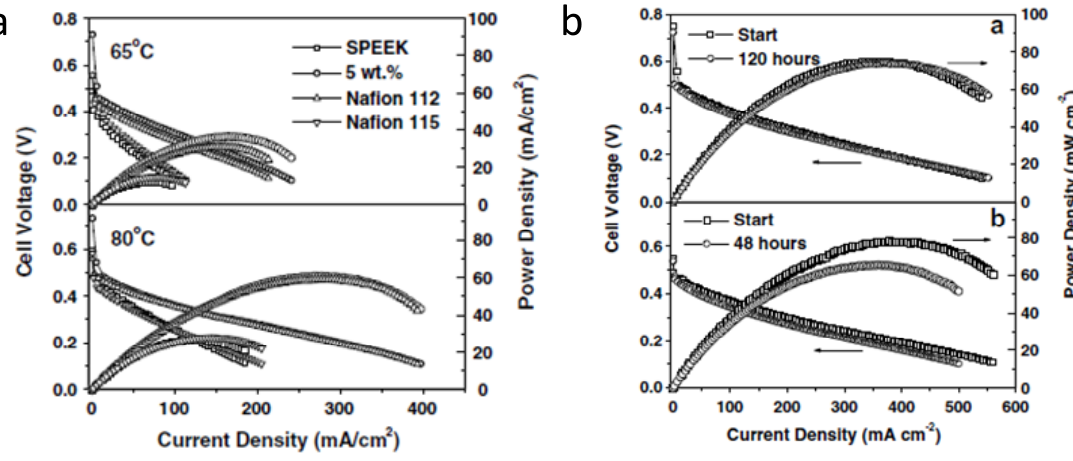
Figure 11. ( a ) Comparison of the polarization curves of the SPEEK/PSf-ABIm (5 wt % of PSf-ABIm) blend membrane with those of SPEEK, Nafion 112, and Nafion 115 membranes in DMFC at 65 and 80 °C with a methanol concentration of 1 M; ( b ) Long-term performance tests carried out with the (a) SPEEK/PSf-ABIm (3 wt %) blend membrane and (b) Nafion 112 membrane at 80 °C in DMFC with a methanol concentration of 2 M. (Reprinted with permission from [56]. Copyright 2007